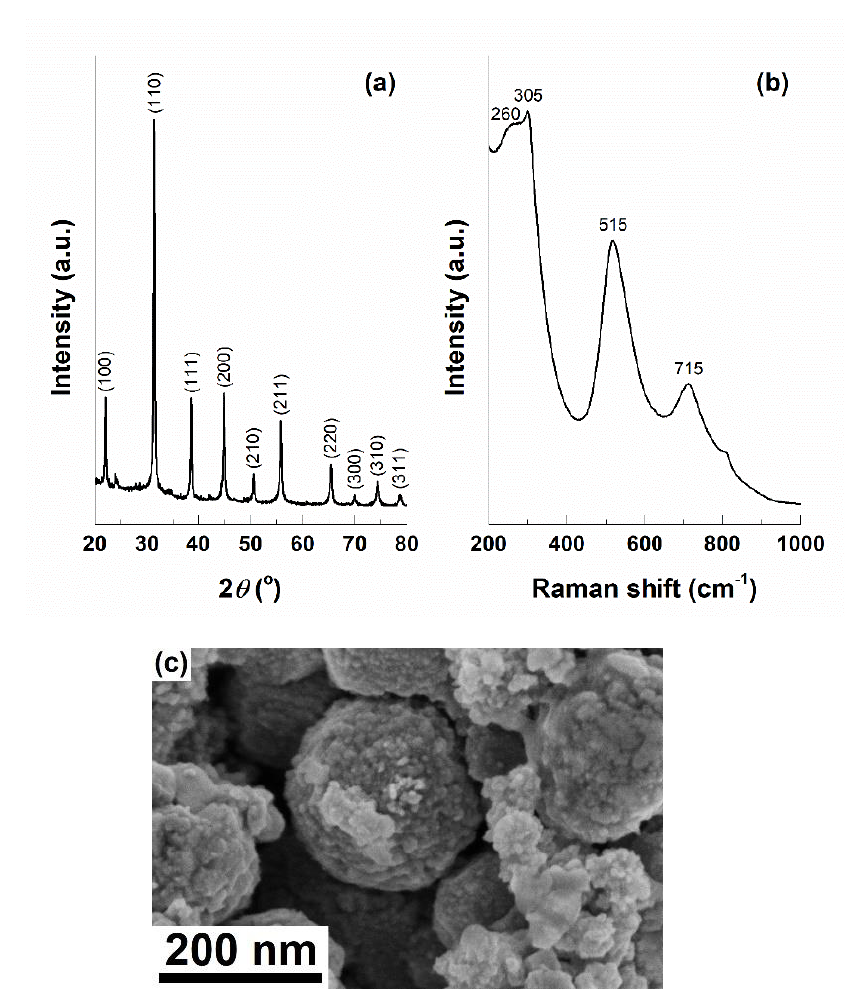
Figure 3. ( a ) XRD pattern, ( b ) Raman spectrum and ( c ) SEM image of barium titanate (BT ) powder.